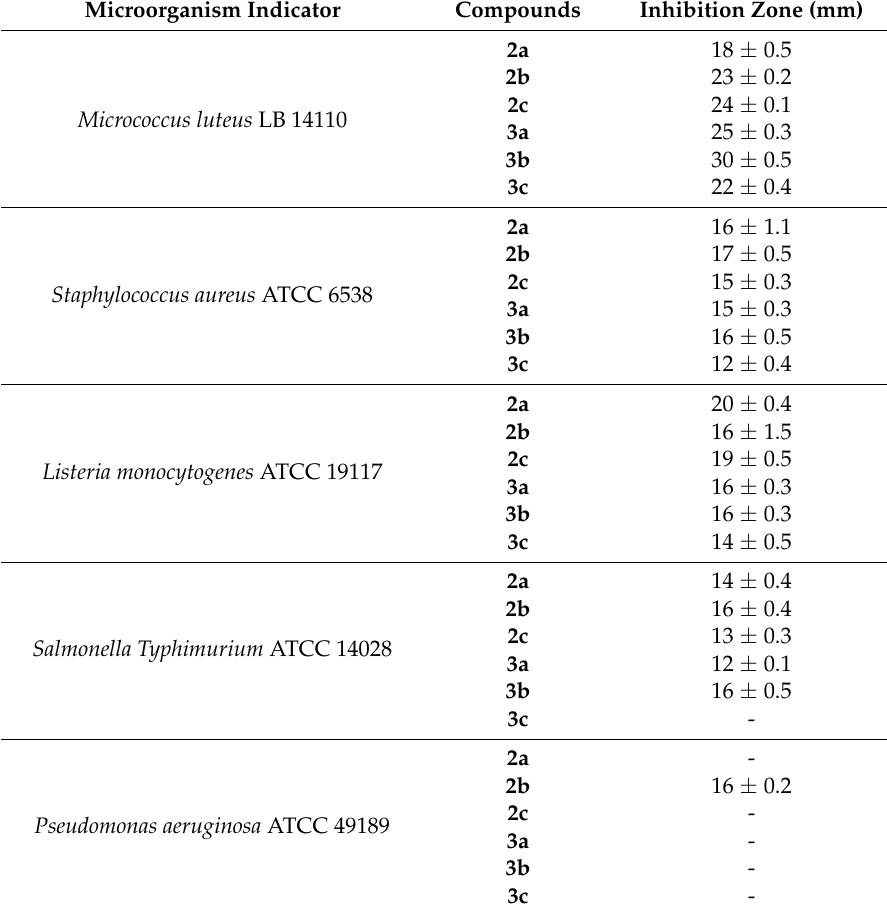
Table 4. Antibacterial activity of the synthesized palladium bis- N -heterocyclic carbene complexes ( 2a – c ) and Palladium PEPPSI-type complexes ( 3a – c ). Microorganism